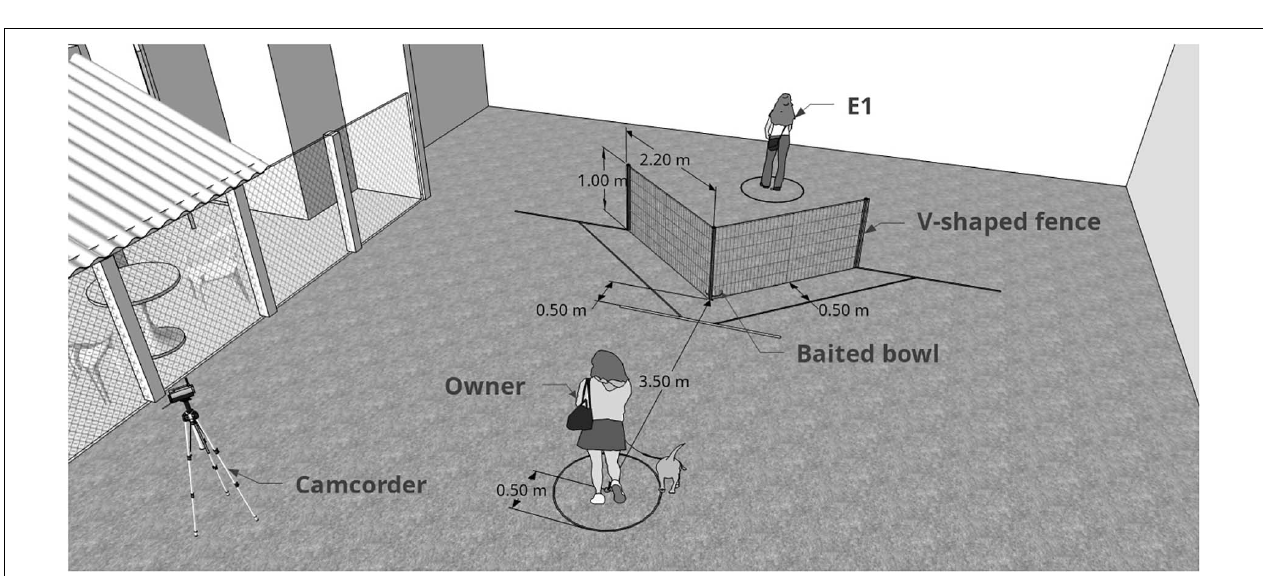
FIGURE 2 | Graphic representation of the moment when the subject was about to be released and start the test. E1 (demonstrator) had already baited the bowl and was distant from the fence, facing the opposite side). The difference between pre-test and test is the presence of the demonstrator. Measurements shown are those from the real